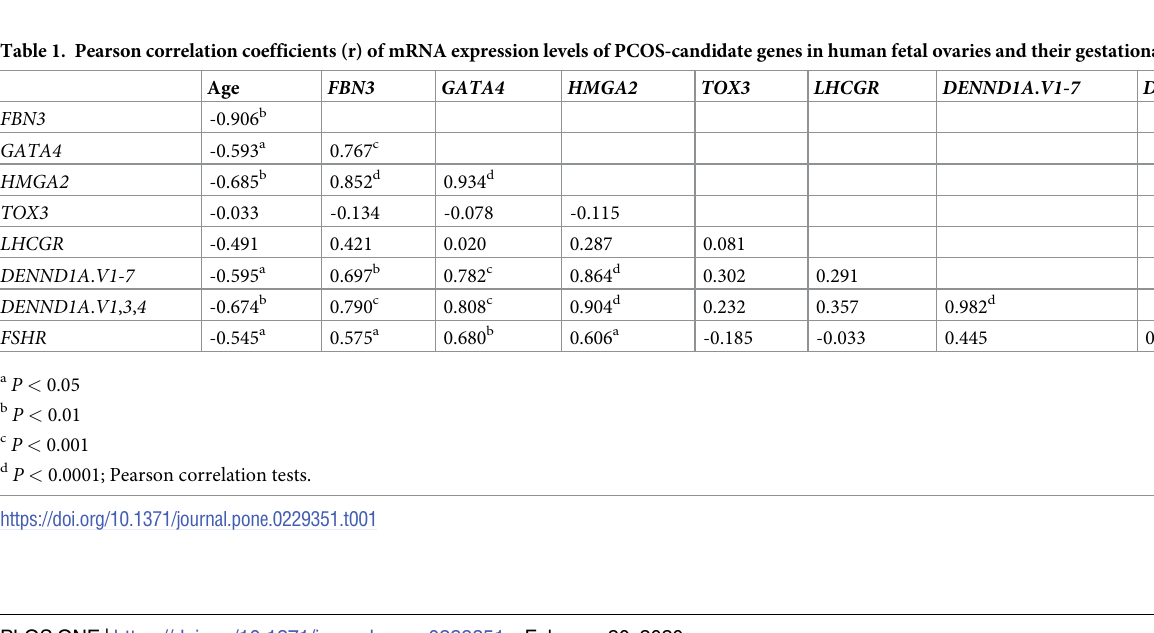
Fig 1. Scatter plot of mRNA expression levels of some PCOS candidate genes analysed in human fetal ovaries (n = 15, 8–20 weeks of gestation). Pearson correlation coefficient (r) test was used to analyse the data. P values are shown in Table 1.